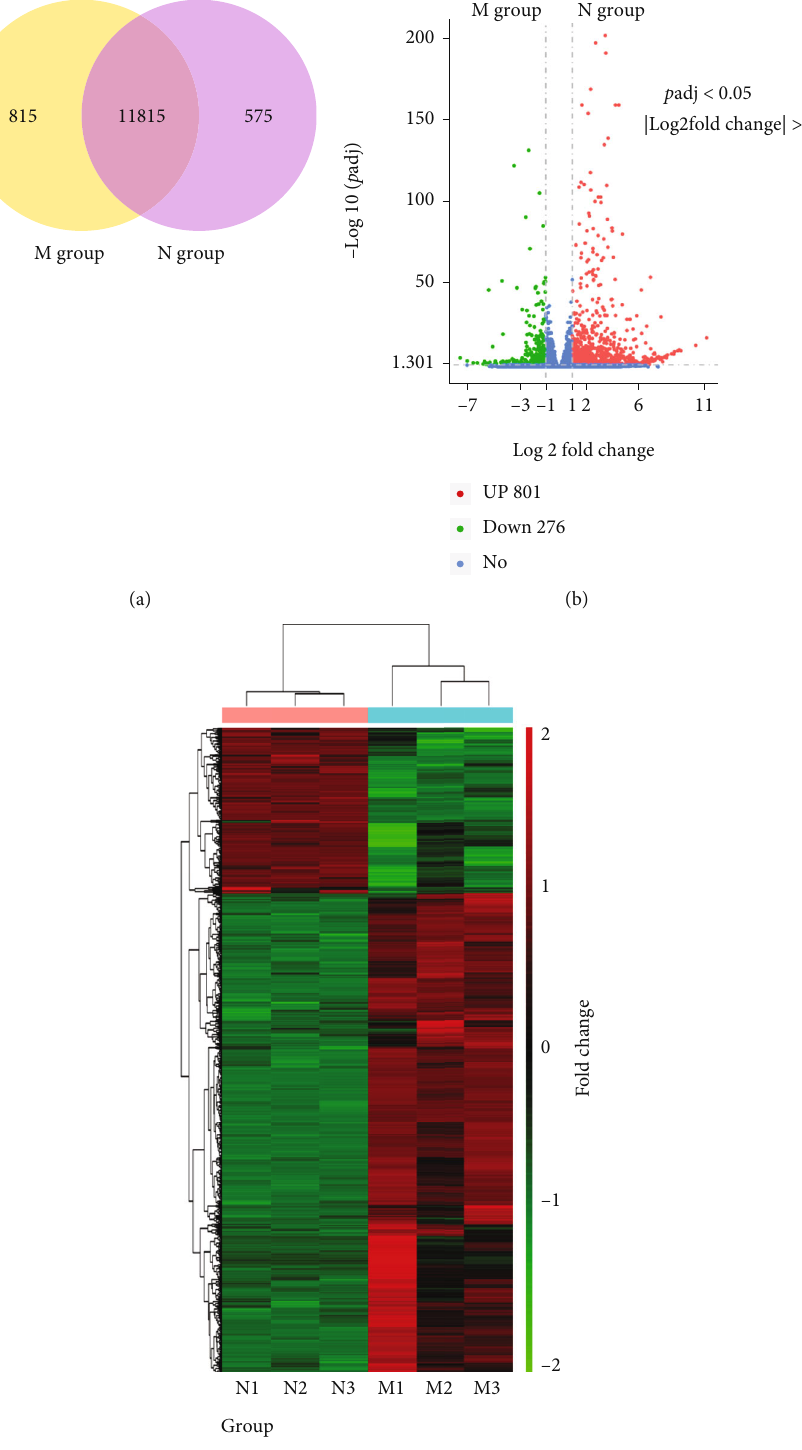
Figure 1: M group and N group represent nucleus pulposus cells isolated from ruptured IVD and normal IVD, respectively. (a) Totally 11815 genes were coexpressed in both groups, (b) among which 801 were upregulated and 276 were downregulated. (c) Heatmap of di ff erentially expressed genes between the two cell groups with 3 samples in each